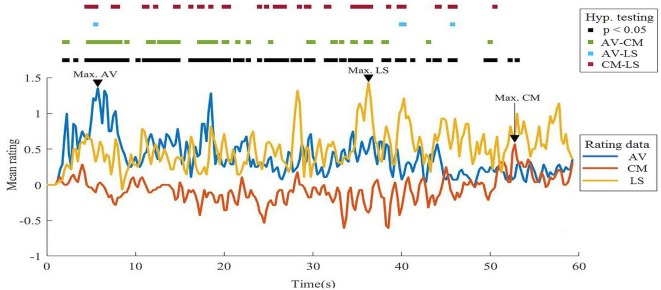
Comparison of mean likeability ratings on overlapped 500 ms epochs. AV, adventure video; CM, comedy video; LS, landscape video.